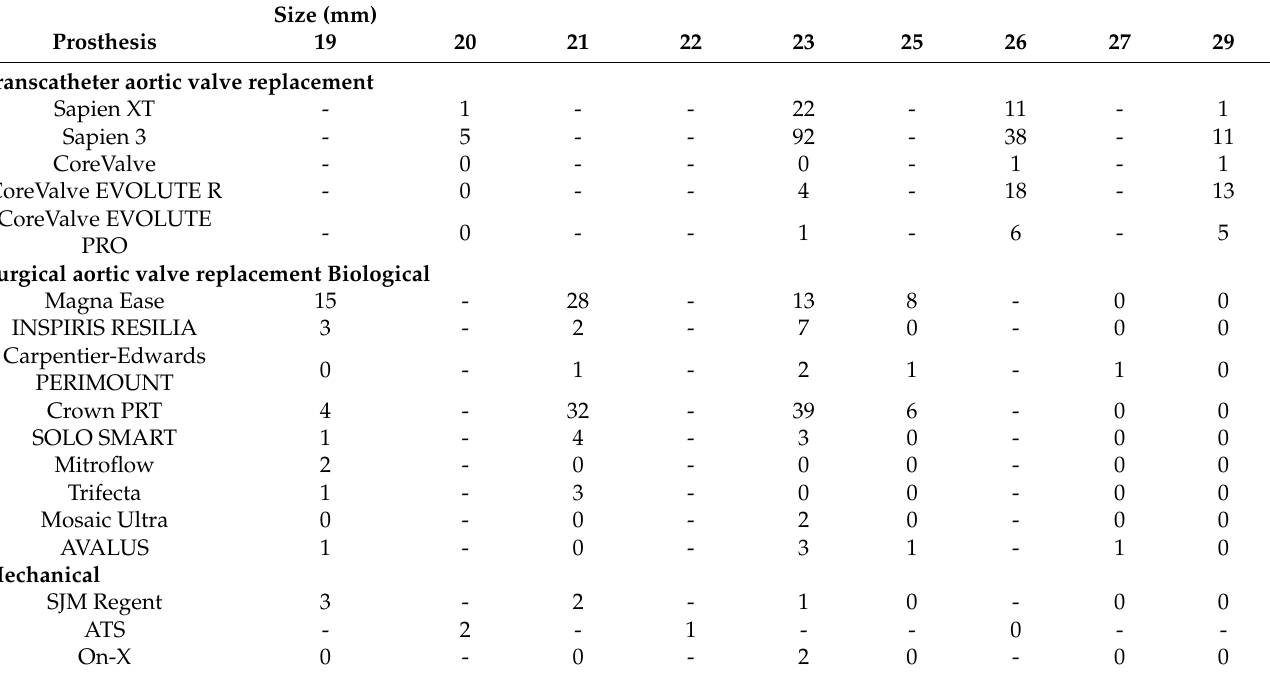
Table 2. Prosthesis used in this